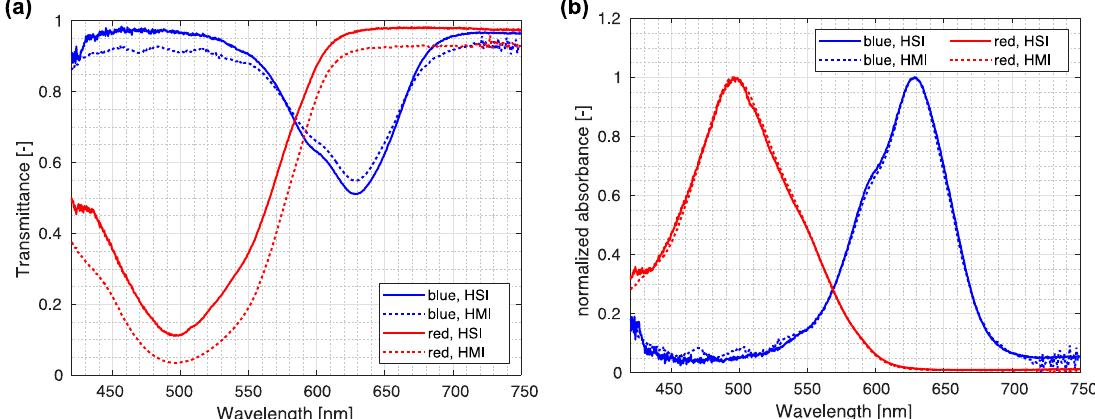
Figure 7. Comparison between HMI and HSI spectra. ( a ) Direct comparison of spectra acquired using custom-made HMI and HSI systems. ( b ) Normalized absorbance spectra obtained by custom-made HMI and HSI systems.